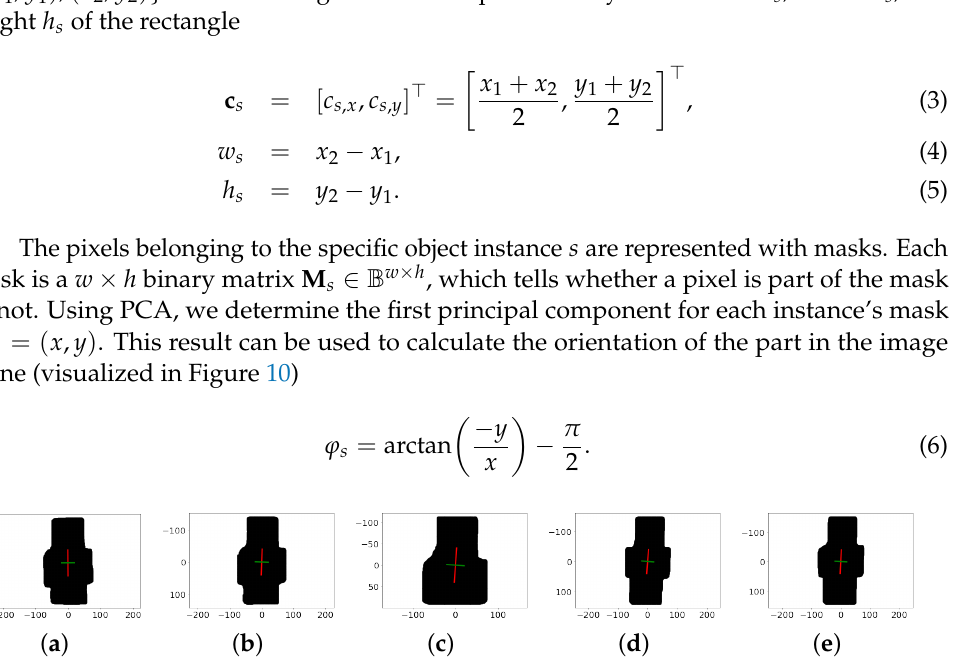
Figure 10. The extracted peg mask for different executions of the copper ring insertion task. Red and green lines show the principal directions and determine the mask’s orientation. ( a ) ∆ p x = − 10 mm; ( b ) ∆ p x = − 5 mm; ( c ) ∆ p x = 0 mm; ( d ) ∆ p x = 5 mm; ( e ) ∆ p x = 10